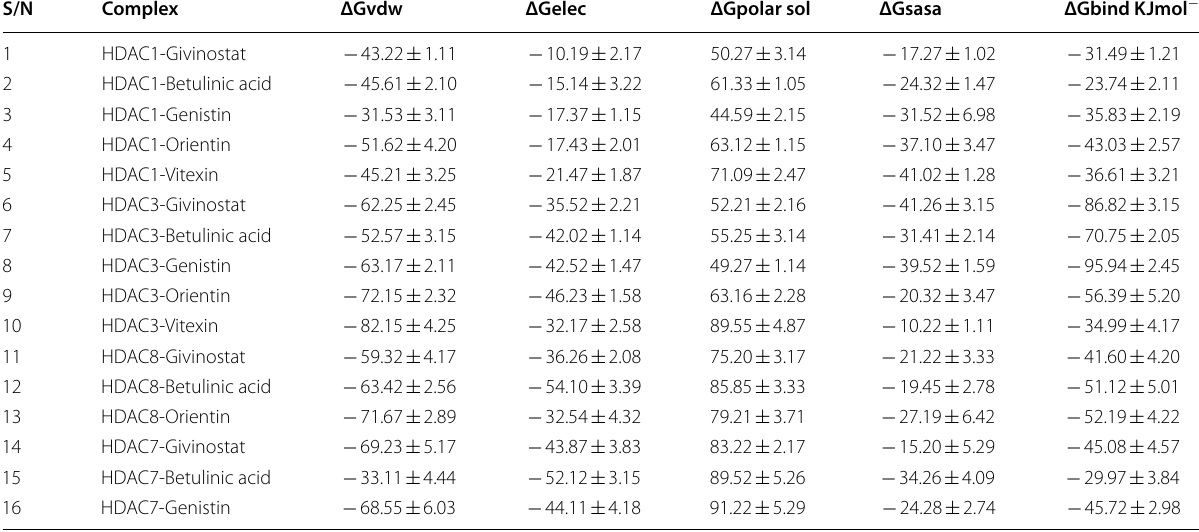
Table 3 Binding free energies of selected protein–ligand complexes S/N Complex